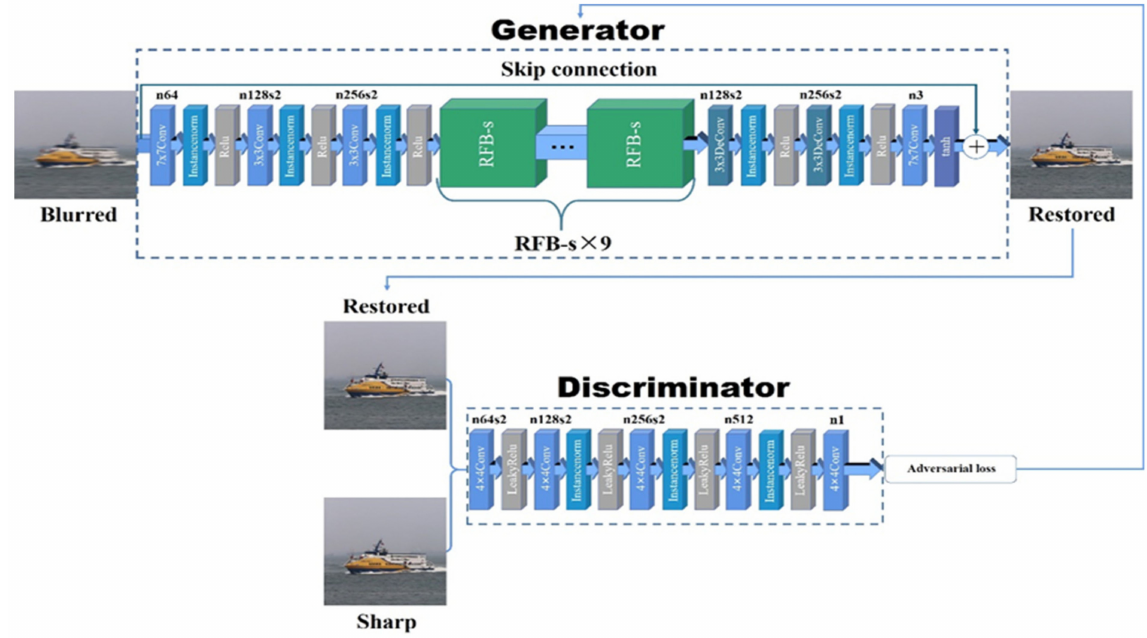
Figure 1. The architecture of the SharpGAN network. The generator of SharpGAN has 4 convolutional layers, 2 deconvolu- tional layers and 9 RFB-s modules, and the discriminator is similar to PatchGAN